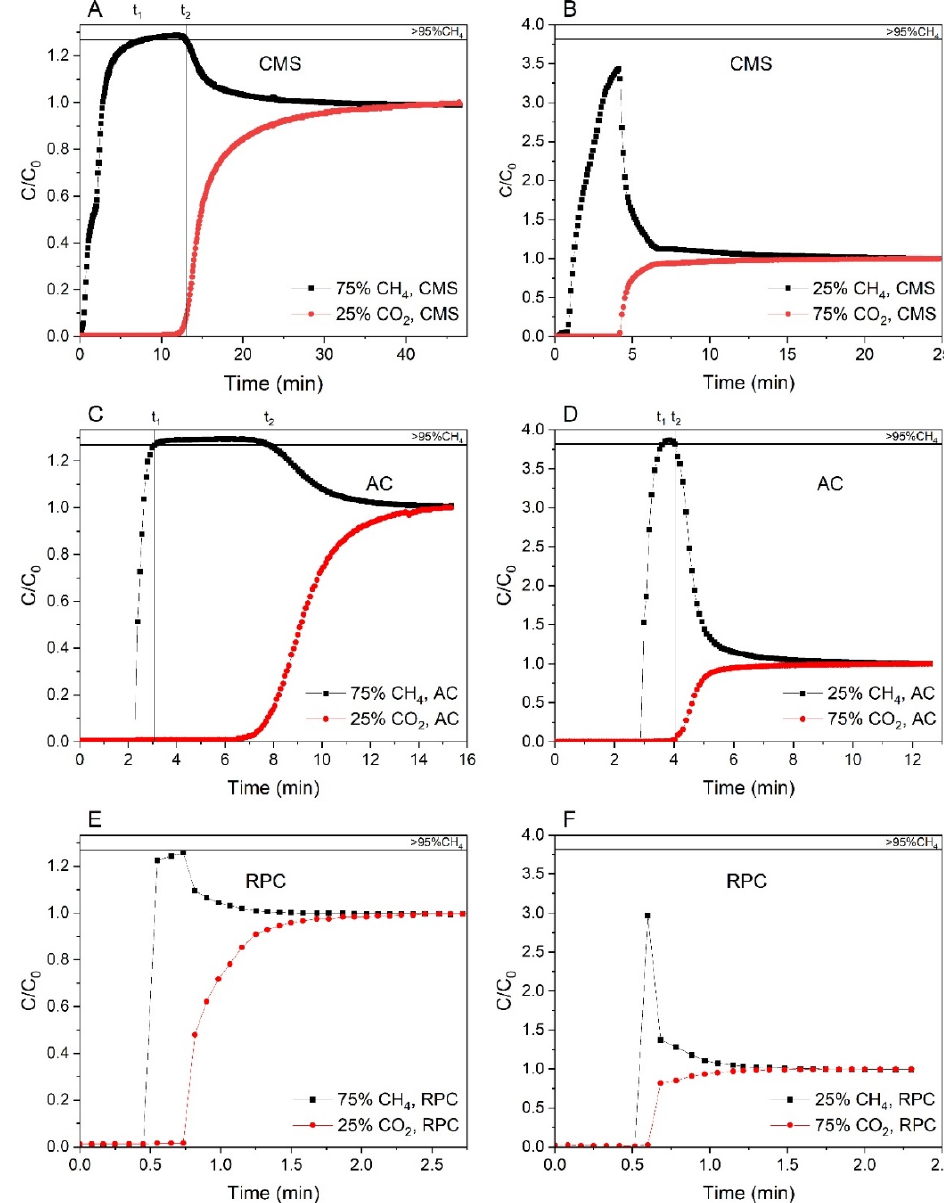
Figure 6. Breakthrough curves for the CMS ( A , B ), AC ( C , D ), and RPC ( E , F ) samples of the methane- rich mixture and the carbon dioxide-rich mixture, respectively, at 1 bar and 293